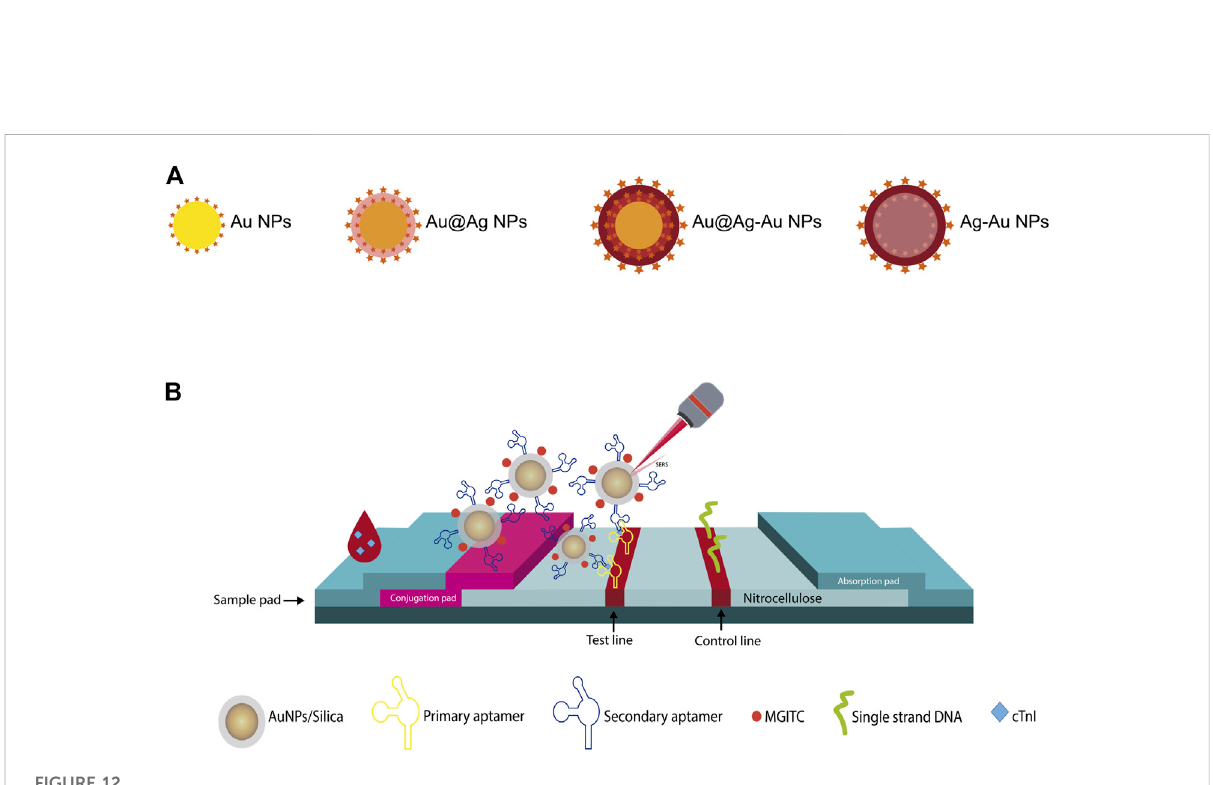
FIGURE 12 (A) ThefourdifferenttypesofSERSsubstrateusedtoelaboratethecaptureprobesintheSERS-basedLFIAstrippresentedbyBaietal.(2018), (B) Schematic representation of the aptamer-based SERS assay on paper platform, adapted from Tu et al.